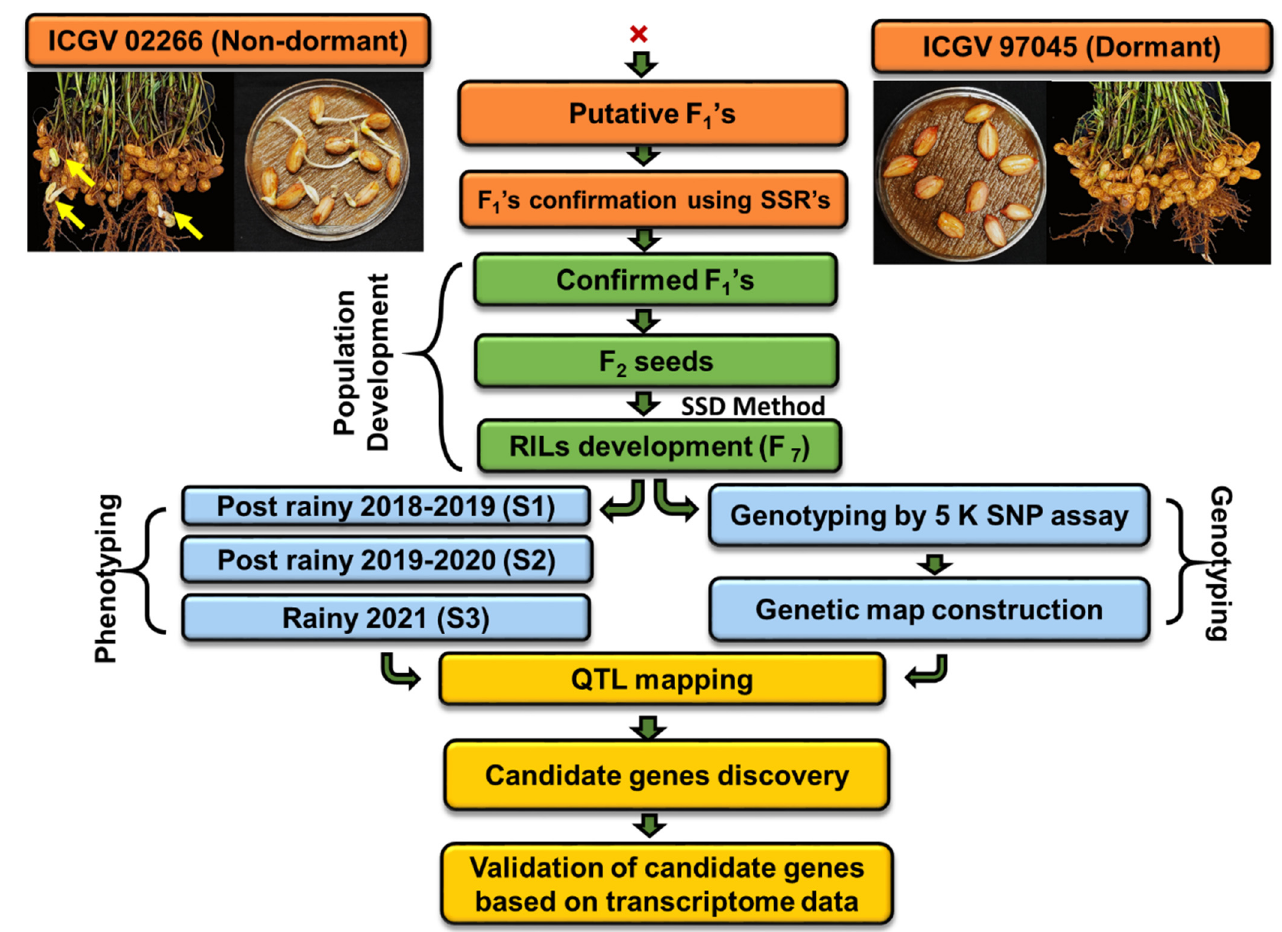
Figure 1. Flow chart of RIL population development, genotyping, and phenotyping for fresh seed dormancy. The RIL population (ICGV 02266 × ICGV 97045) was developed using the single seed decent (SSD) method followed by three-season phenotyping, genotyping, QTL mapping, candidate gene discovery, and differential gene expression analysis using transcriptome data of dormant Tifrunner and non-dormant ICGV 91114.